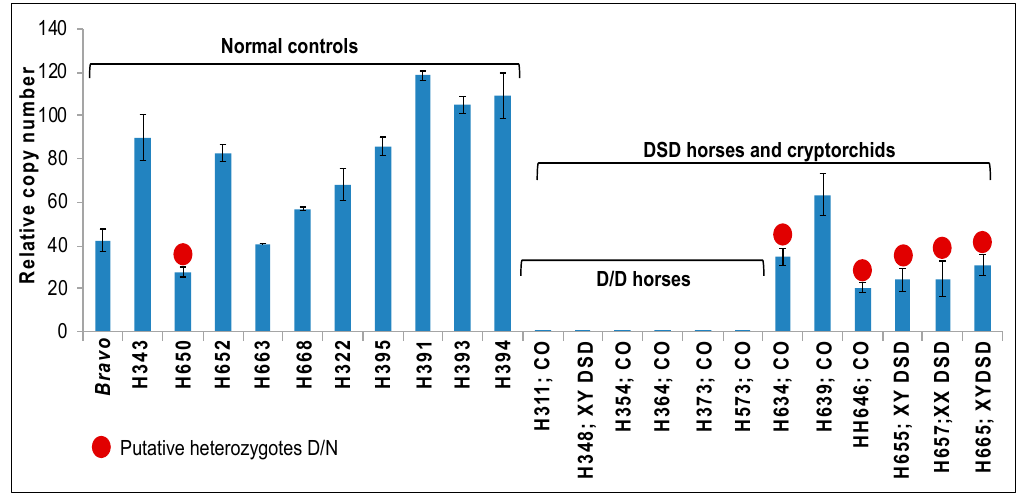
Figure 4. Quantitative PCR for the detection of putative deletion heterozygotes. Y-axis: relative copy number; x-axis: individual horses tested, including 11 normal controls at the left and 12 horses with DSDs at the right; CO—cryptorchid; red dots denote putative heterozygotes based on relative copy numbers.